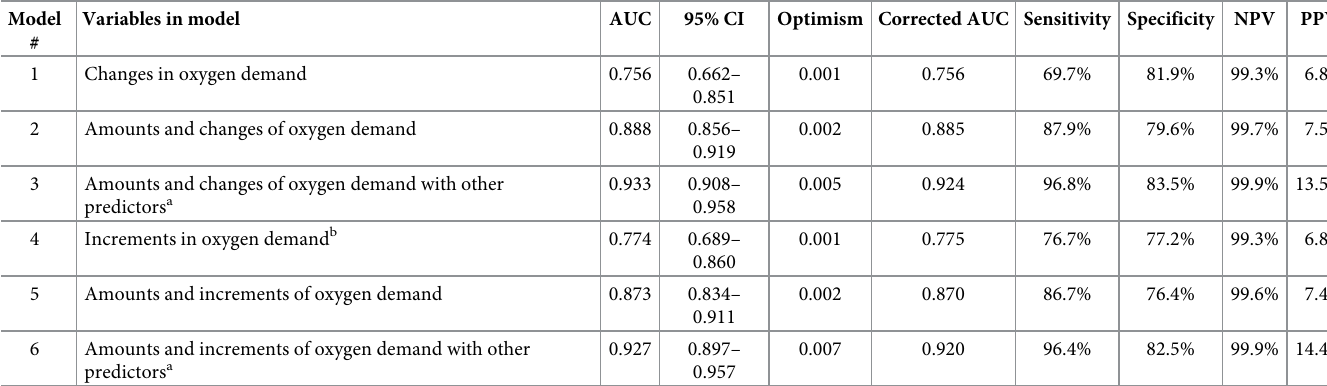
Table 3. Accuracy for prediction of MV usage by changes in oxygen